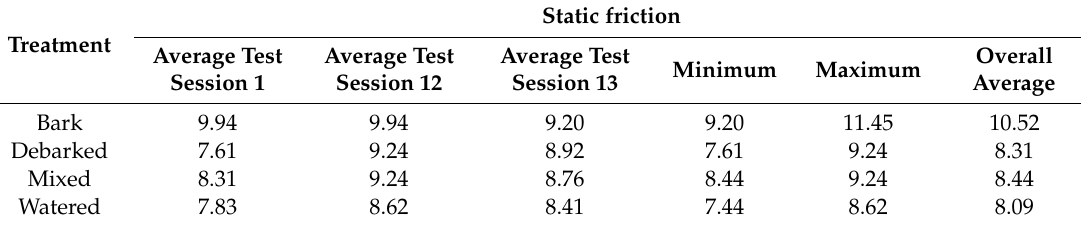
Figure 6. Mass reduction (%) of test logs within the four treatments after 7 and 21 days. Table 1. Average static frictions in N Pull / kg Log of test sessions 1, 12, and 13 as well as minimum, maximum, and overall